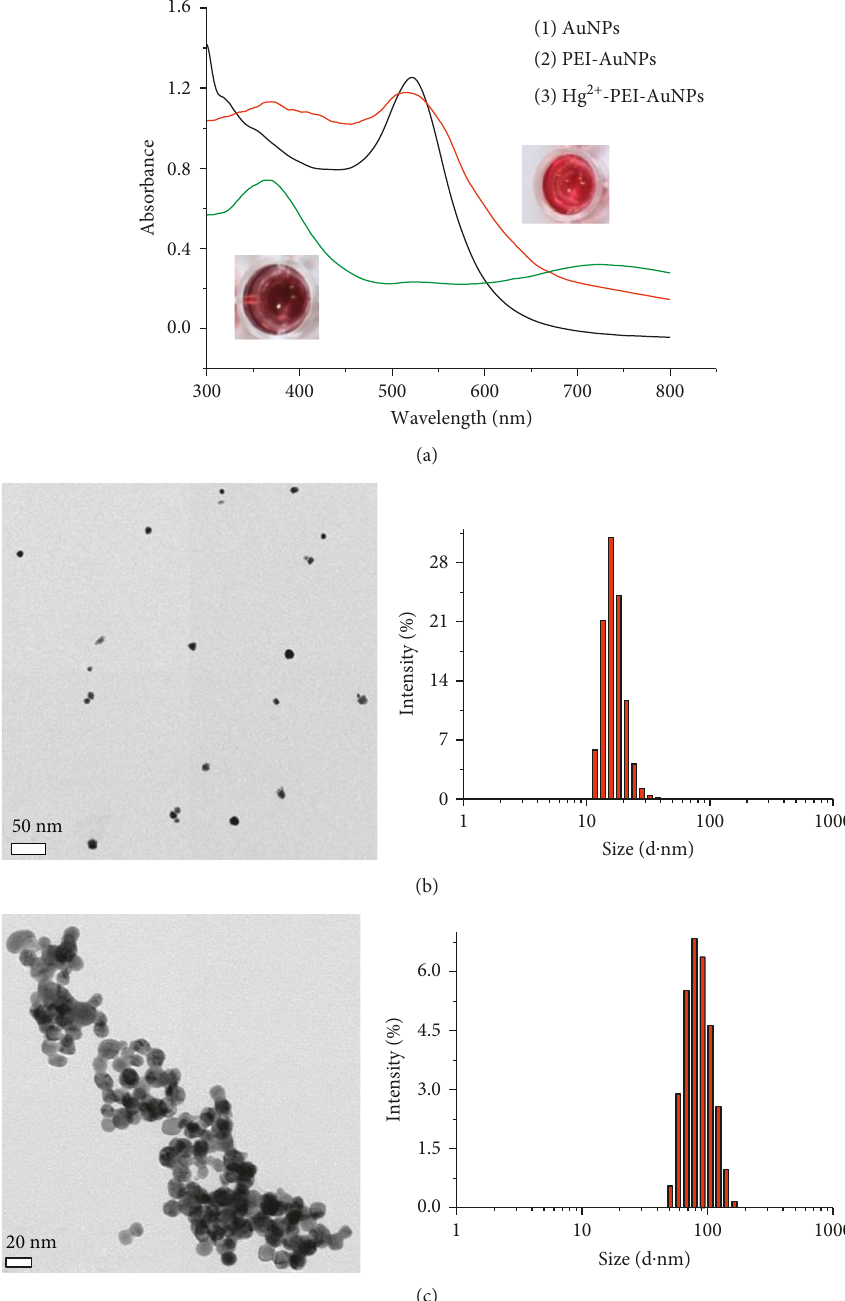
Figure 1: (a) UV-Vis absorption spectra of (1) AuNPs (black line), (2) PEI-AuNPs (red line), and (3) PEI-AuNPs conjugated with Hg 2+ (green line). (b) TEM image of PEI-AuNPs (left) and the corresponding particle-size distribution histogram (right). (c) TEM image of PEI- AuNPs conjugated with Hg 2+ (left) and particle-size distribution histogram